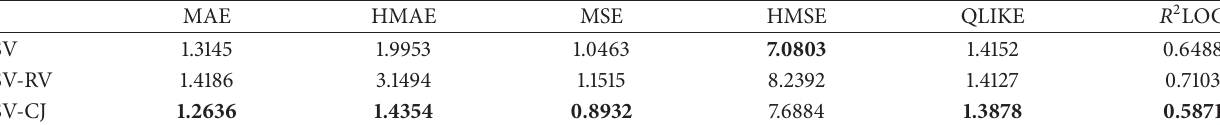
Table 5: The loss functions of out-of-sample forecasts.